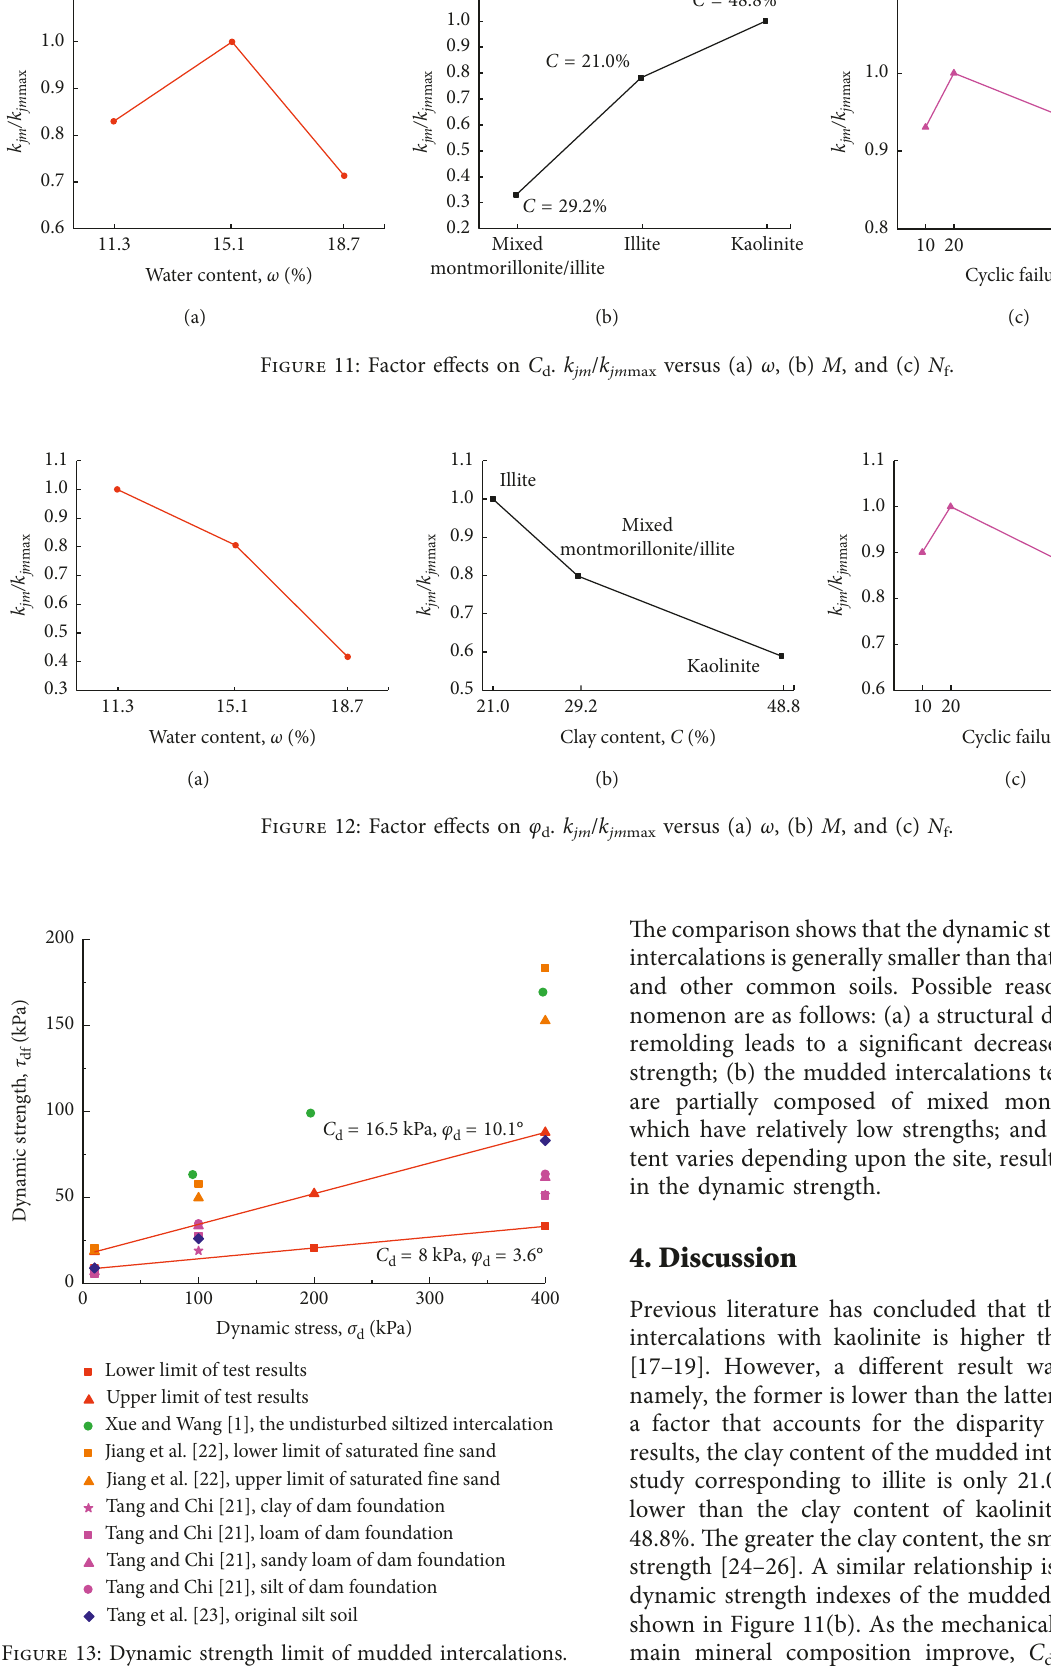
Figure 13: Dynamic strength limit of mudded